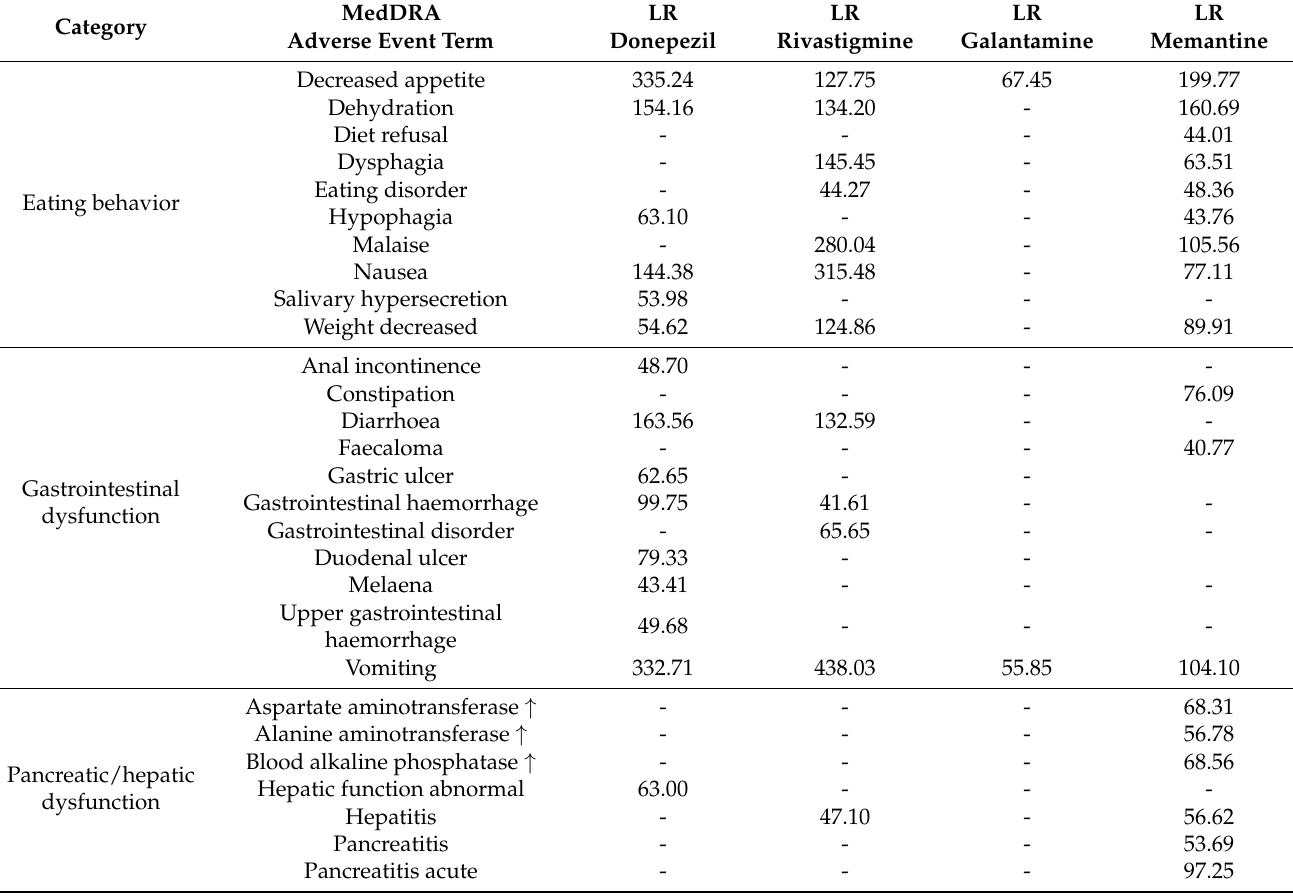
Table 1. Gastrointestinal adverse events. Relevant symptoms for the four investigated drugs were selected from http: //drugcentral.org/ (LR: Likelihood